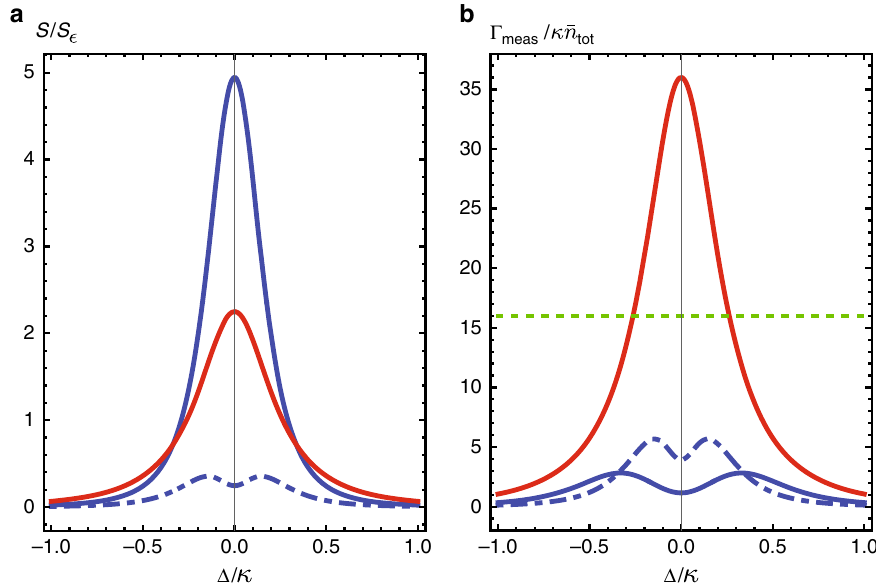
Fig. 2 Signal power and measurement rate. a Signal power S and b measurement rate Γ meas against drive detuning Δ for three 2-mode non-Hermitian sensors. Blue dot-dashed: Reciprocal system with exceptional point but no gain, described by Eq. (31) with γ 1 = 0, γ 2 = 0.2 κ , J = 0.2 κ . Blue solid: Reciprocal system with exceptional point and gain, described by Eq. (31) with γ 1 = 0, γ 2 = − 0.3 κ , J = 0.325 κ . Despite a higher signal power, introducing gain does not enhance the measurement rate due to the corresponding increased level of measurement noise. Neither of these systems beat the fundamental reciprocal- system bound in Eq. (30) (green dotted). Red: nonreciprocal system in Eq. (35) ( γ 1 = κ , γ 2 = 0.5 κ , J = 1.5 κ , ν 2 = 0). It yields a measurement rate which appreciably exceeds the reciprocal-system bound for a wide range of